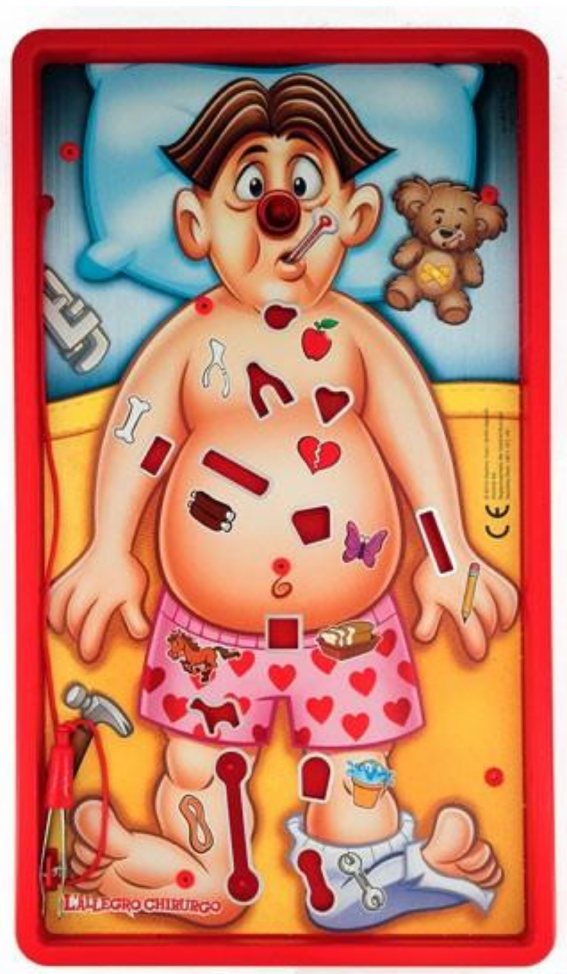
Figure 2. The Doctor Game task consisted in extracting as many objects as possible from the “patient” without touching the metal border. If an error occurred, the nose will emit a red light and the board will